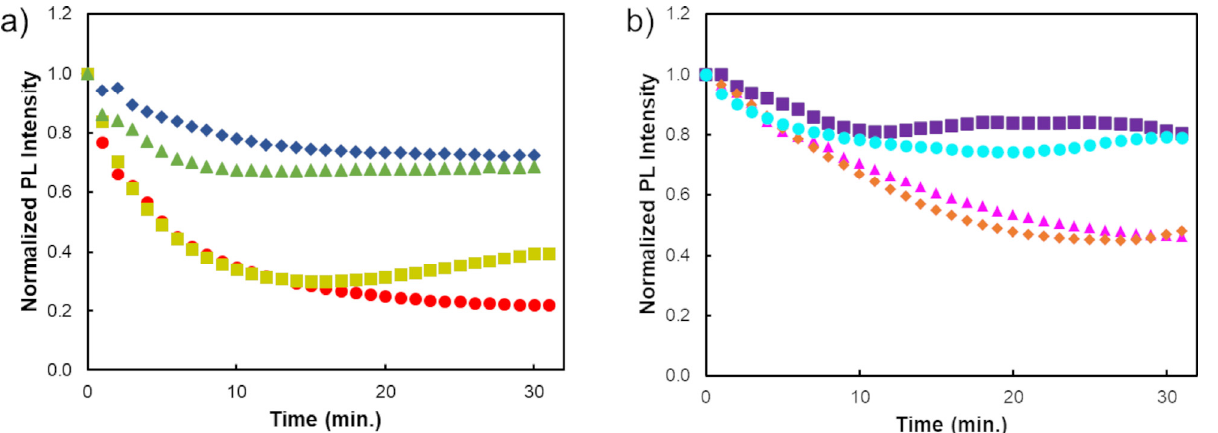
Figure 4. Evolution of the maximum PL intensity throughout 30 min of ( a ) binary CdTe QDs capped with GSH ( ● ), MES ( ▲ ), TMA ( ■ ) and MPA ( ♦ ) and ( b ) ternary AIS QDs stabilized with MPA ( ■ ) and TMA ( ♦ ) as well as AIS/ZnS QDs capped with D- Pen ( ▲ ) and TMA ( ● ).